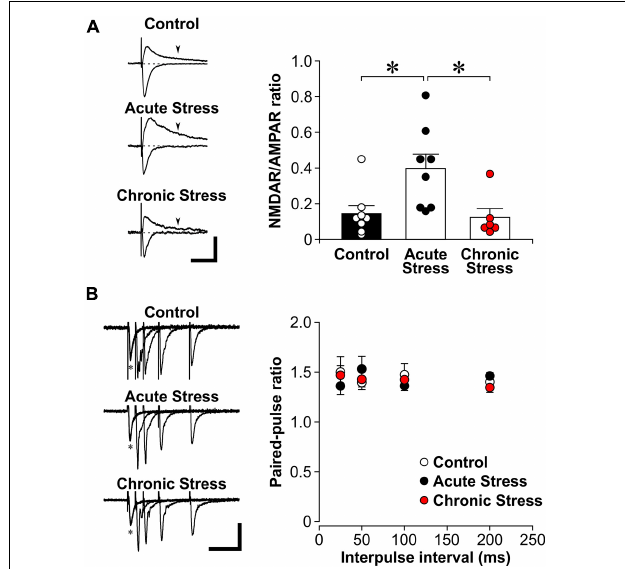
FIGURE 1 | Acute stress enhances the NMDAR/AMPAR ratio. (A) Left : Representative traces of evoked excitatory postsynaptic currents (EPSCs) while voltage clamping hippocampal CA1 neurons at either –60 mV (inward currents) or +40 mV (outward currents). The AMPAR component is represented by the EPSC amplitude recorded at –60 mV. The NMDAR component is estimated by the magnitude of +40 current at 150 ms post stimulation (arrowheads), when the AMPAR component has returned to baseline (dotted line). Scale bar = 100 pA, 100 ms. Right: Histograms of NMDAR/AMPAR ratio in EPSCs recorded from control (8 recordings, 4 rats), acutely stressed rats (8 recordings, 4 rats) and chronically stressed rats (6 recordings, 3 rats). Mean ± SEM. ∗ p < 0.05, post hoc Wilcoxon test after Kruskal-Wallis test. (B) Left: Representative traces of paired-pulse stimulation of evoked field excitatory postsynaptic potential (fEPSP) at different interpulse intervals ( ∗ represent the first pulse, followed by the second pulse at 25, 50, 100, or 200 ms in overlapping traces) that were recorded from brain slices of control, acutely stressed and chronically stressed rats. Scale bar = 0.2 mV, 100 ms. Right: Scatter plots show the paired-pulse ratios of fEPSP slope in control (12 recordings, 5 rats), acutely stressed rats (12 recordings, 5 rats) and chronically stressed rats (15 recordings, 4 rats). Mean ±